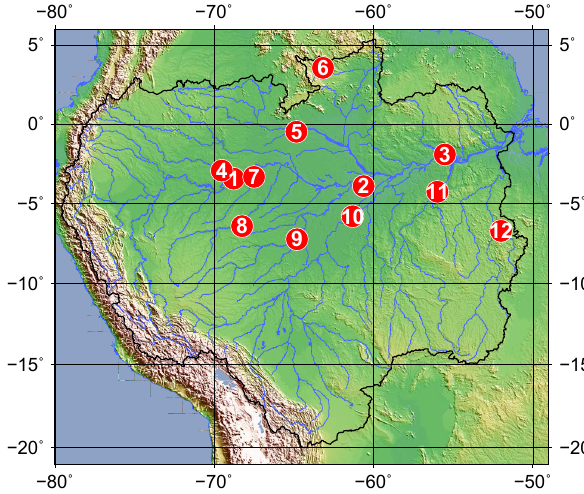
Figure 4. Map of the 12 in situ stations used to evaluate assimila- tion performance: (1) São Paulo de Olivenca (Solimões), (2) Man- acapuru (Solimões), (3) Óbidos (Amazonas), (4) Ipiranga (Putu- mayo/Icá), (5) Serrinha (Negro), (6) Uaicás (Branco), (7) Porto Seguro (Jutaí), (8) Santos Dumont (Juruá), (9) Lábrea (Purus), (10) Manicoré (Madeira), (11) Itaituba (Tapajós), and (12) Boa Sorte